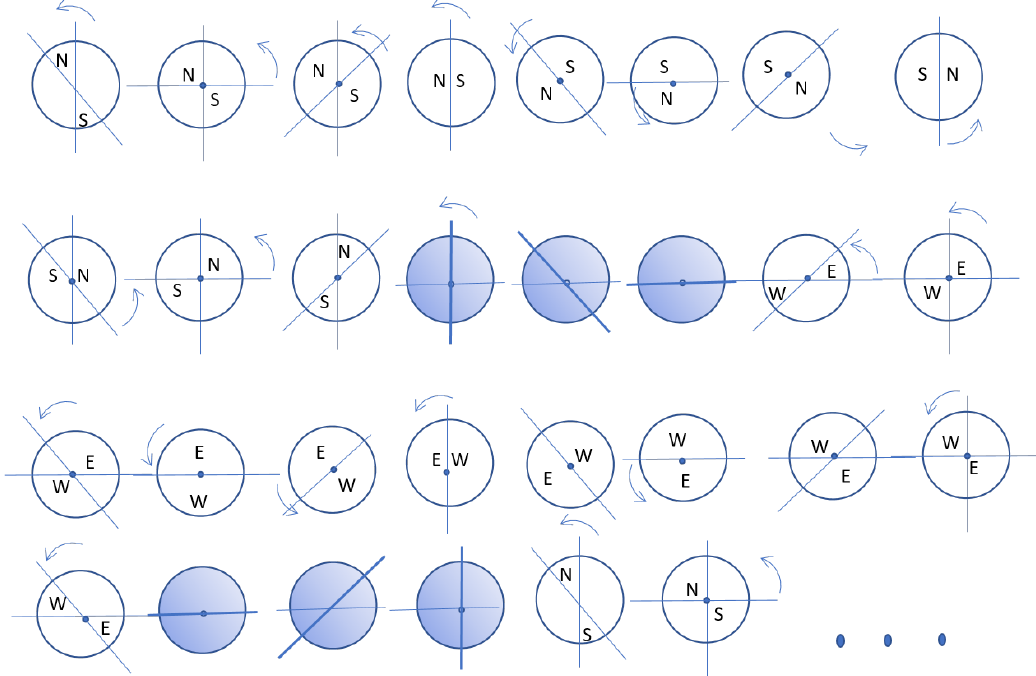
Figure 20. Signaling sequence for U-turn allowed variant (360 ◦ ) with one (90 ◦ ) void